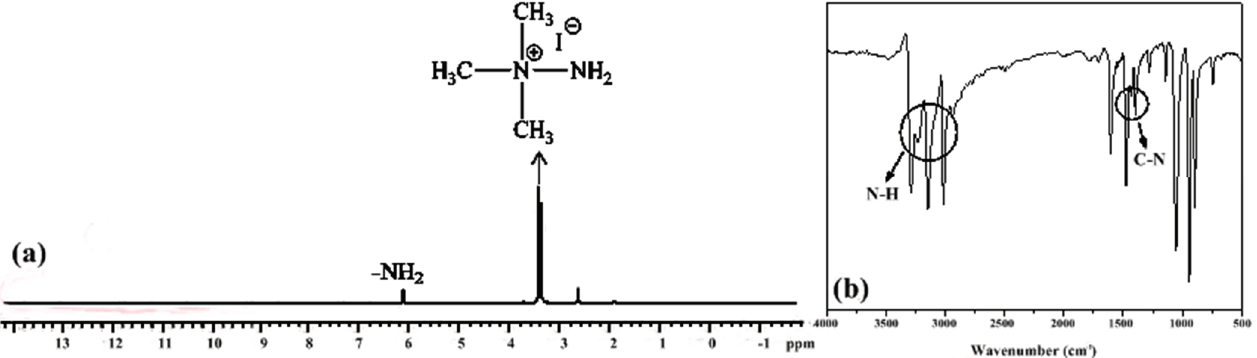
Figure 2. 1 H-NMR ( a ) and FT-IR spectrum ( b ) of the synthesized N , N , N -trimethylhydrazinium iodide, [TMH] + [I] −